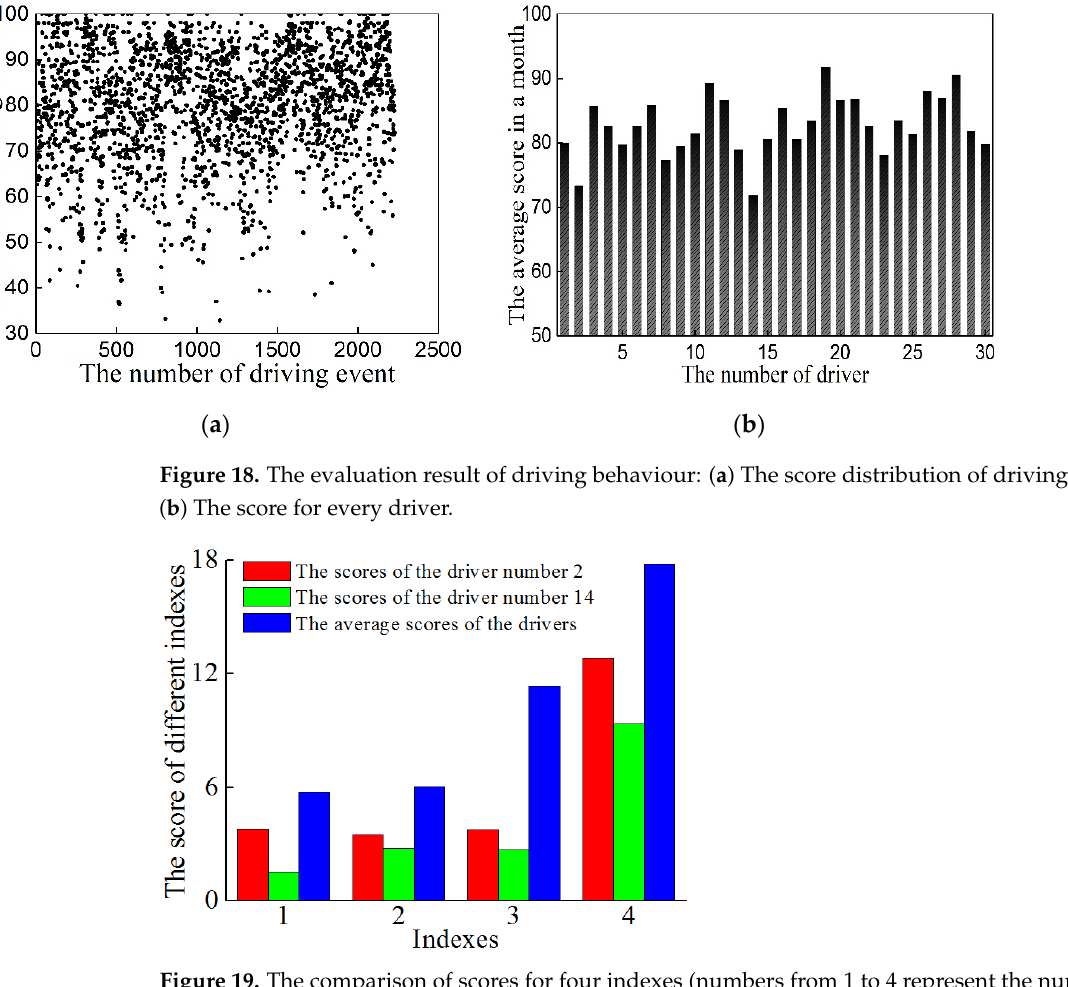
Figure 17. The evaluation flow chart of driving behaviour.